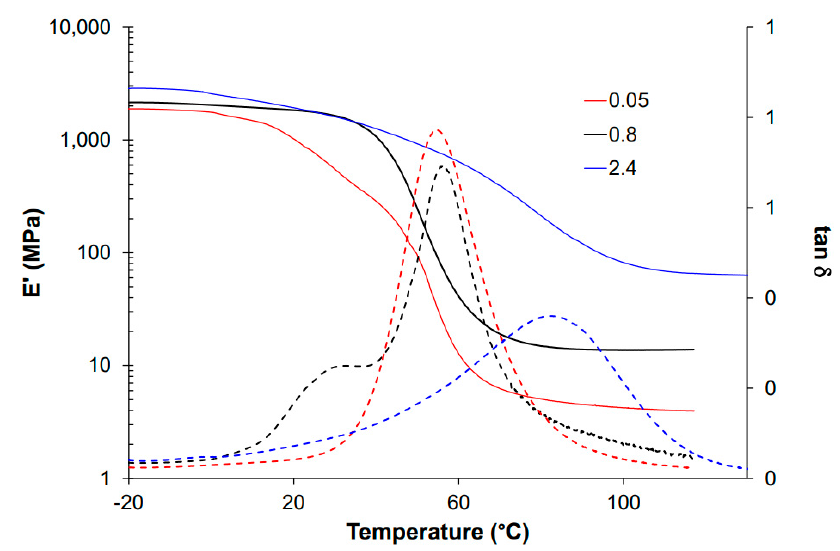
Figure 4. Alpha relaxations as influenced by the amount of coupling agent (GMA).